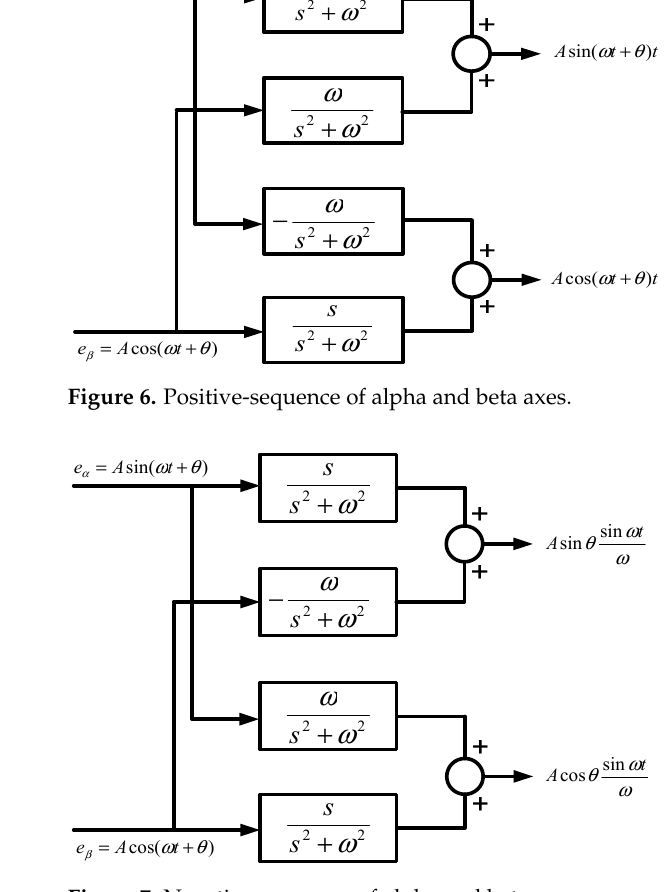
Figure 7. Negative-sequence of alpha and beta axes.